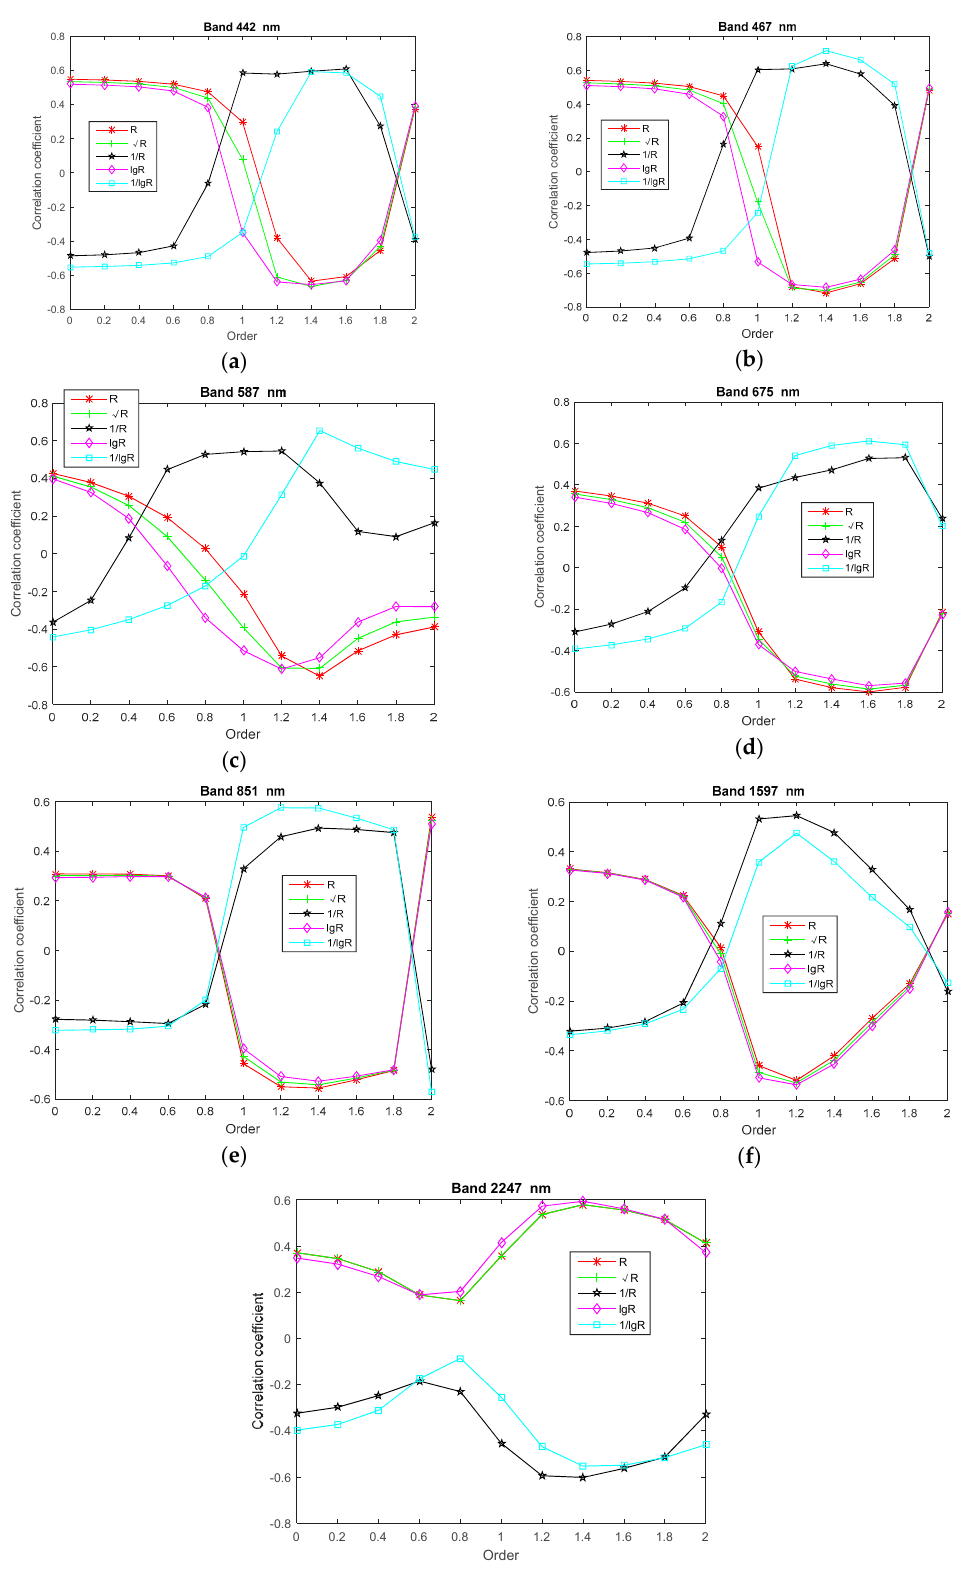
Figure 7. The trend of correlation coe ffi cient for partial bands of Landsat 8 image in each order di ff erential: ( a ) 442 nm; ( b ) 467 nm; ( c ) 587 nm; ( d ) 675 nm ; ( e ) 851 nm ; ( f ) 1597 nm; and ( g ) 2247